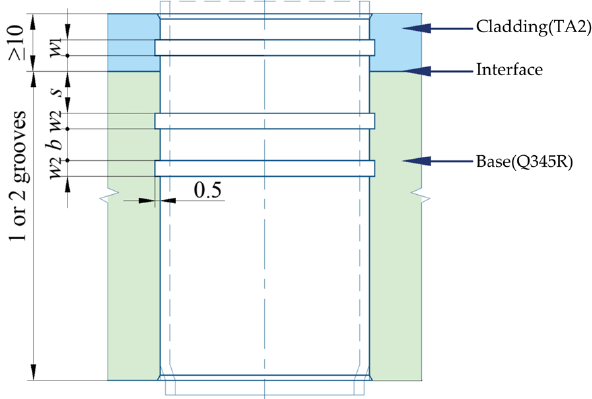
Figure 9. The structure and dimension of grooves.